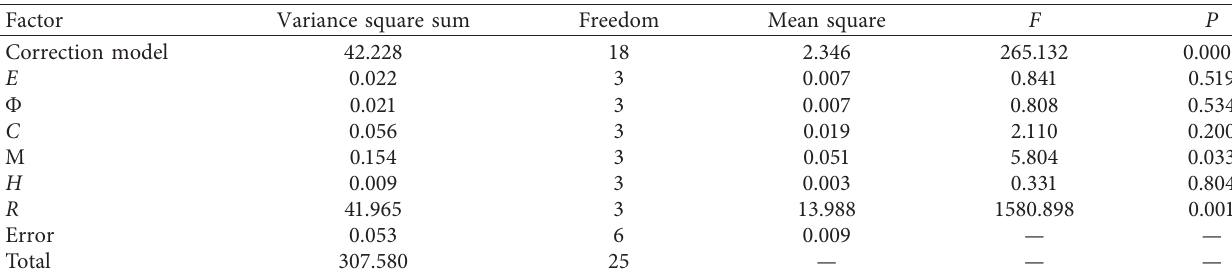
Figure 4: Variation curves of peak stress, distressed zone, and stress concentration zone by the change of any factor. Table 2: Variance analysis for the distressed